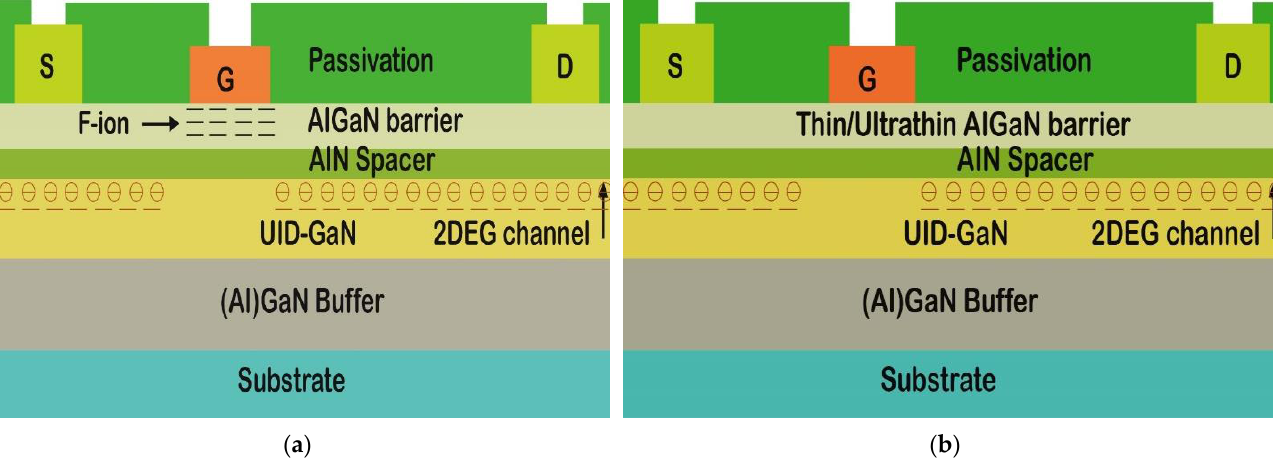
Figure 20. ( a ) Normally-off HEMTs with fluorine implantation structure.; ( b ) normally-off HEMTs with thin/ultrathin-barrier structure.